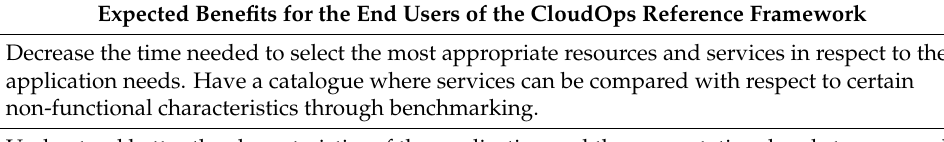
Figure 6. Sequence diagram of the proposed Cloud Self-healing workflow through the reference framework.